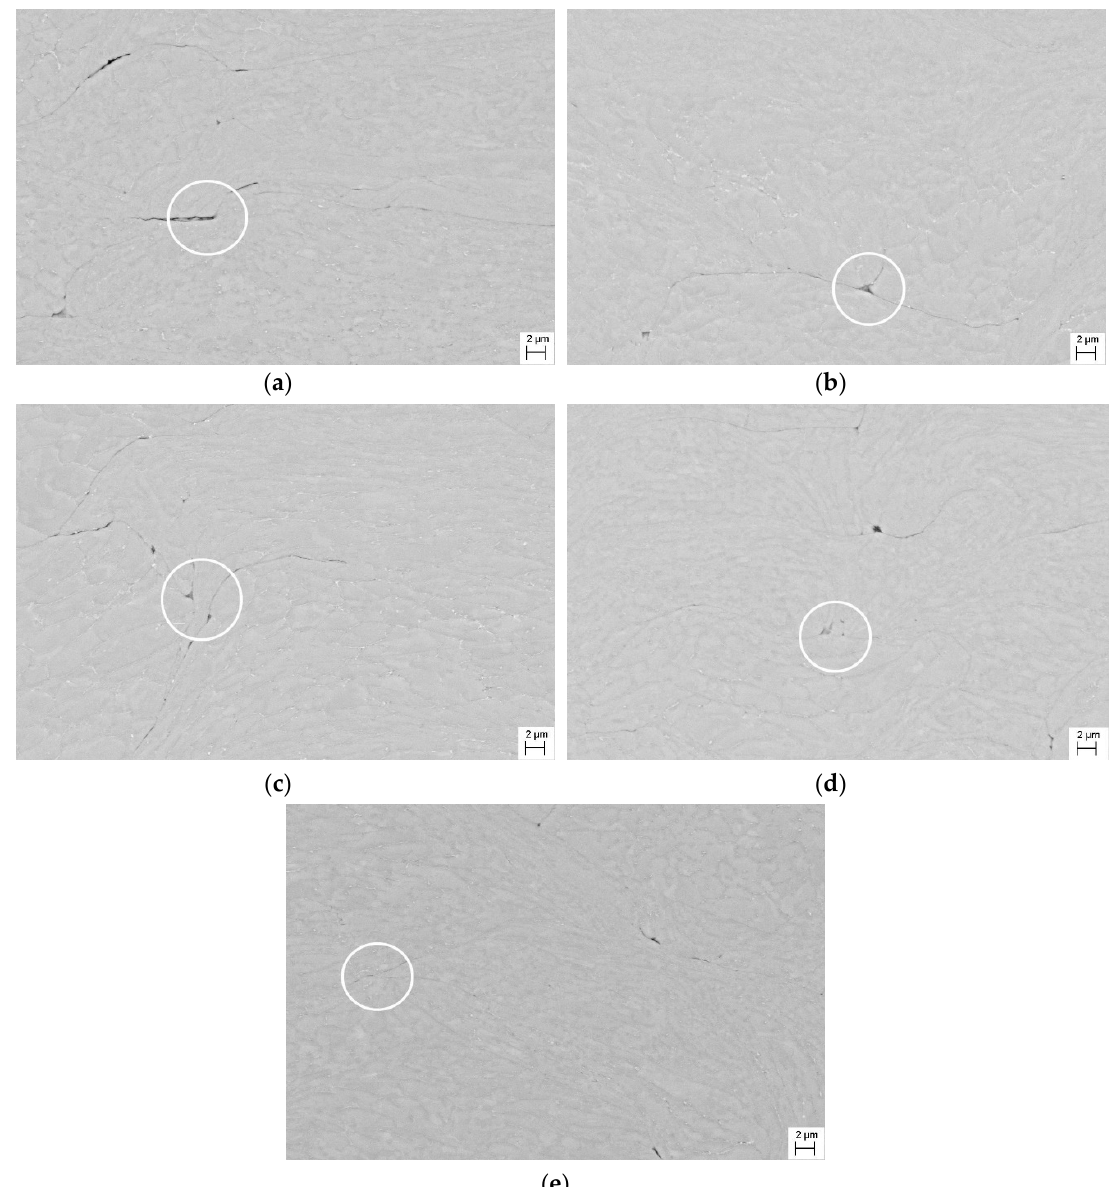
Figure 8. Microstructures of cold-sprayed Al6061 coatings sprayed with different spray parameters ( a ) 35 bar; 300 °C, ( b ) 35 bar; 350 °C, ( c ) 30 bar; 400 °C, ( d ) 35 bar; 400 °C, and ( e ) 40 bar; 400 °C. Circles show the cross-points between particles. FESEM images.